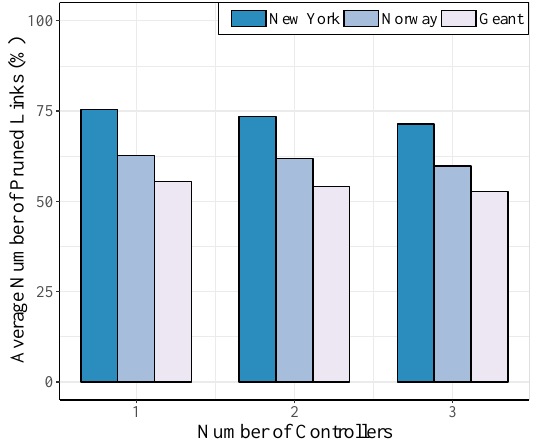
Figure 4. Average number of pruned links in the three topologies varying the number of